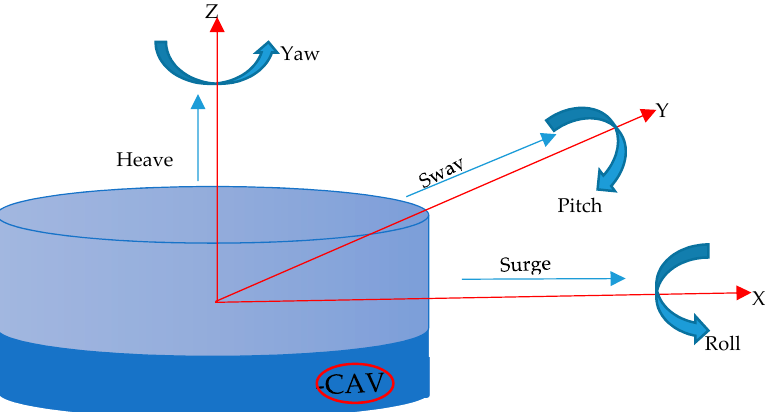
Figure 3. The 6DoF of a floating CALM buoy, showing the heave, yaw, sway, pitch, surge and roll motions.